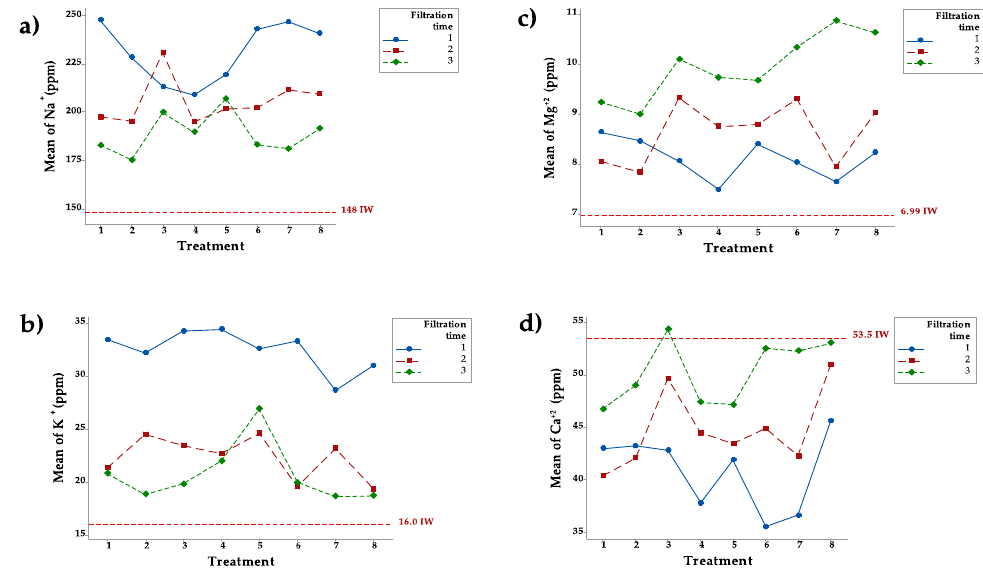
Figure 2. Concentration of Na + ( a ), K + ( b ), Mg +2 ( c ), and Ca +2 ( d ) in eight treatments after three filtra-